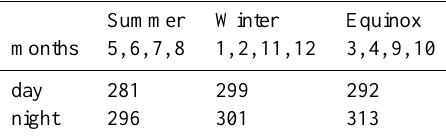
(cid:12) (cid:12) (cid:12) j 50Hz , peak (cid:12) for different